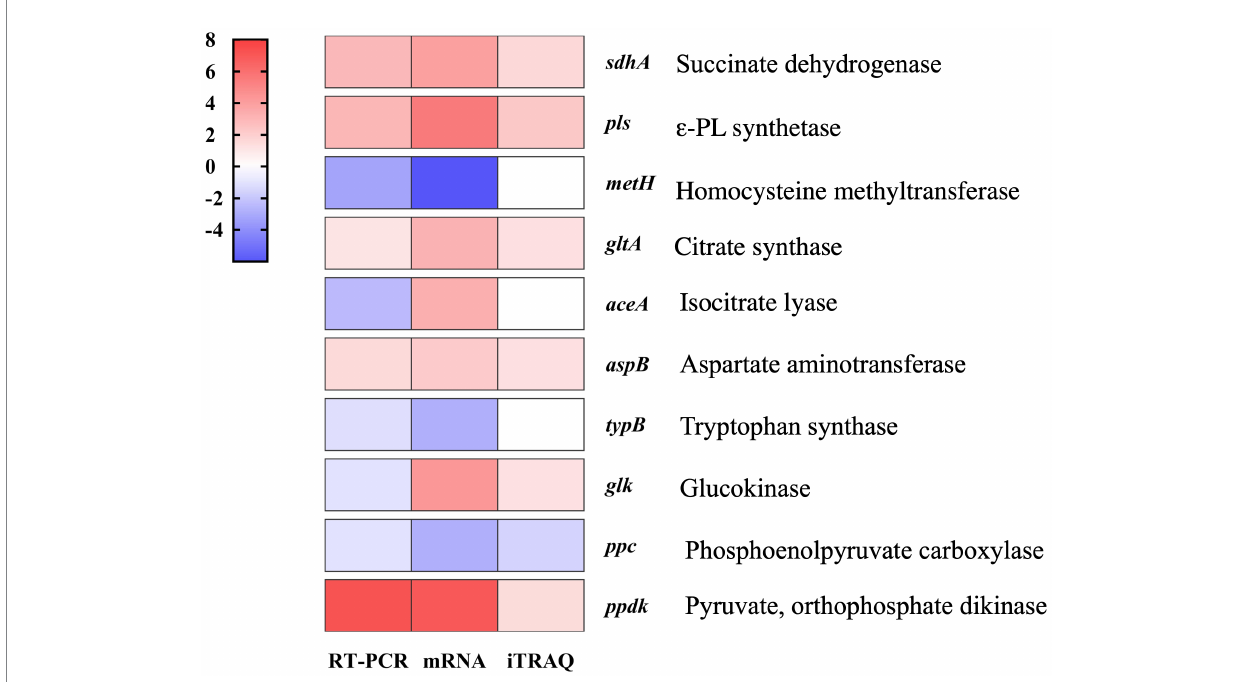
FIGURE 4 Quantitative RT-PCR verification of RNA-sequencing and iTRAQ data obtained from fed-batch fermentations of S. albulus WG-608 and S. albulus M-Z18.